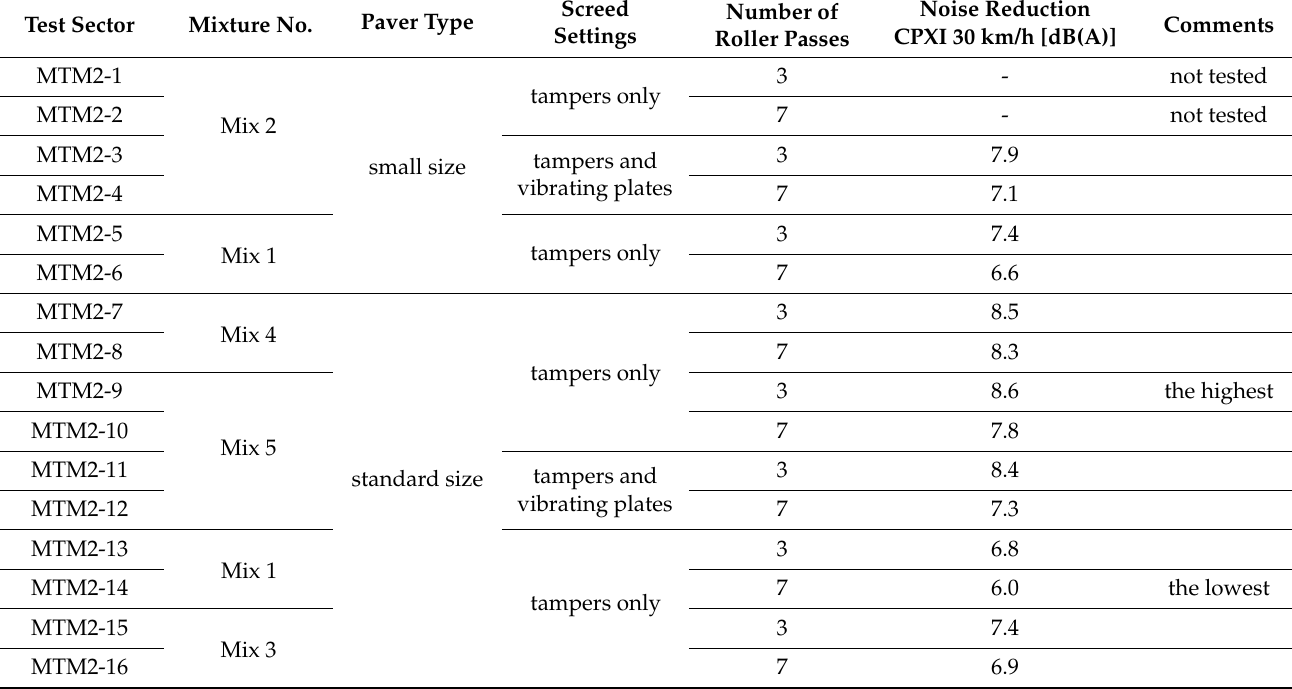
Table 7. Noise reduction of poroelastic mixtures obtained on the second short test section. Test